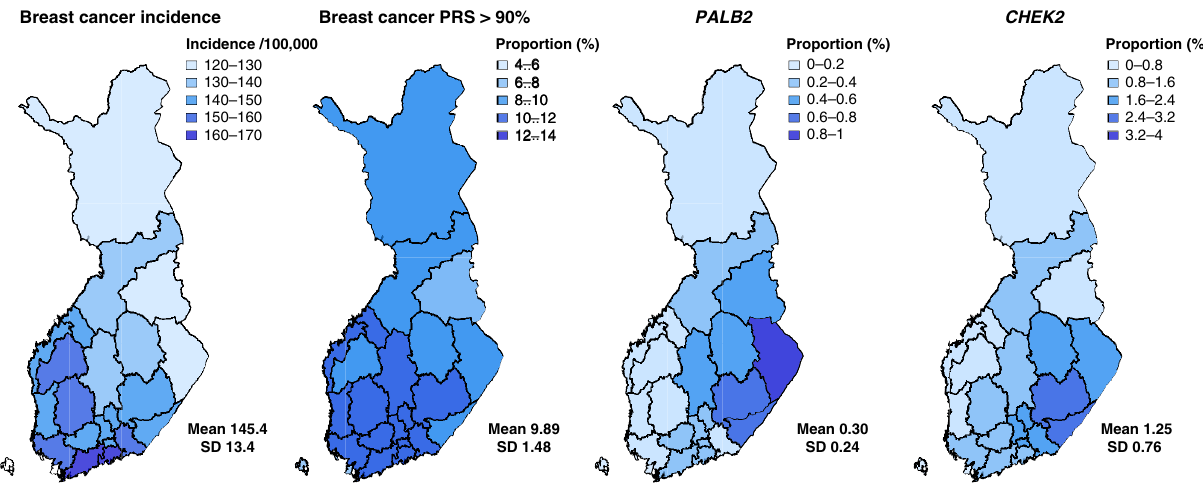
Fig. 1 Geographic variation in genetic risk. The risk is compared to age-standardised breast cancer incidence. The proportion of women with the breast cancer polygenic risk score (PRS) above the 90th percentile in each region is estimated with respect to the PRS distribution of the whole country. The PALB2 and CHEK2 maps show across different regions the proportion of women carrying at least one risk allele for the variants. The areas represent region of birth obtained from Statistics Finland. The national breast cancer incidence in women was obtained from the Finnish Cancer Registry (publicly available at https://cancerregistry. fi /statistics/) with diagnosis C50 (International Classi fi cation of Diseases for Oncology, 3rd edn, ICD-O-3). The incidence represents the mean of 5-year age-standardised incidences (based on the 2014 Finnish population, calculated for each hospital district over 1998 – 2007). The mean and standard deviation were calculated over the different regions. Variants: rs180177102 (c.1592delT) for PALB2 and rs555607708 (c.1100delC) for CHEK2 . CHEK2 and polygenic risk score plots are based on 122,978 women, and PALB2 on 109,371 women. Colour contrasts were chosen approximately based on the standard deviation for each map. Table 2 Risk for breast cancer events in the population in carriers of the PALB2 and CHEK2 frameshift mutations, and in the top decile of the polygenic risk score (PRS).